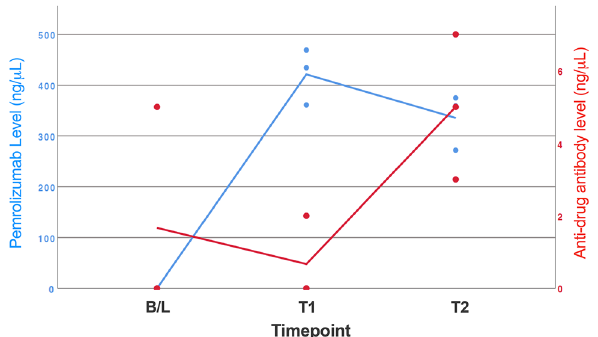
Figure 3. Pembrolizumab drug and anti-drug antibody (ADA) levels in 3 patients with results suggestive of a neutralising ADA . 3/41 patients (7%) with results suggestive of a neutralising ADA are shown. All 3 patients had falling pembrolizumab drug levels and rising ADA between Cycle 2 (T1) and last available time-point (T2; Median Cycle 7 or 21 weeks IQR Cycle 4-13).